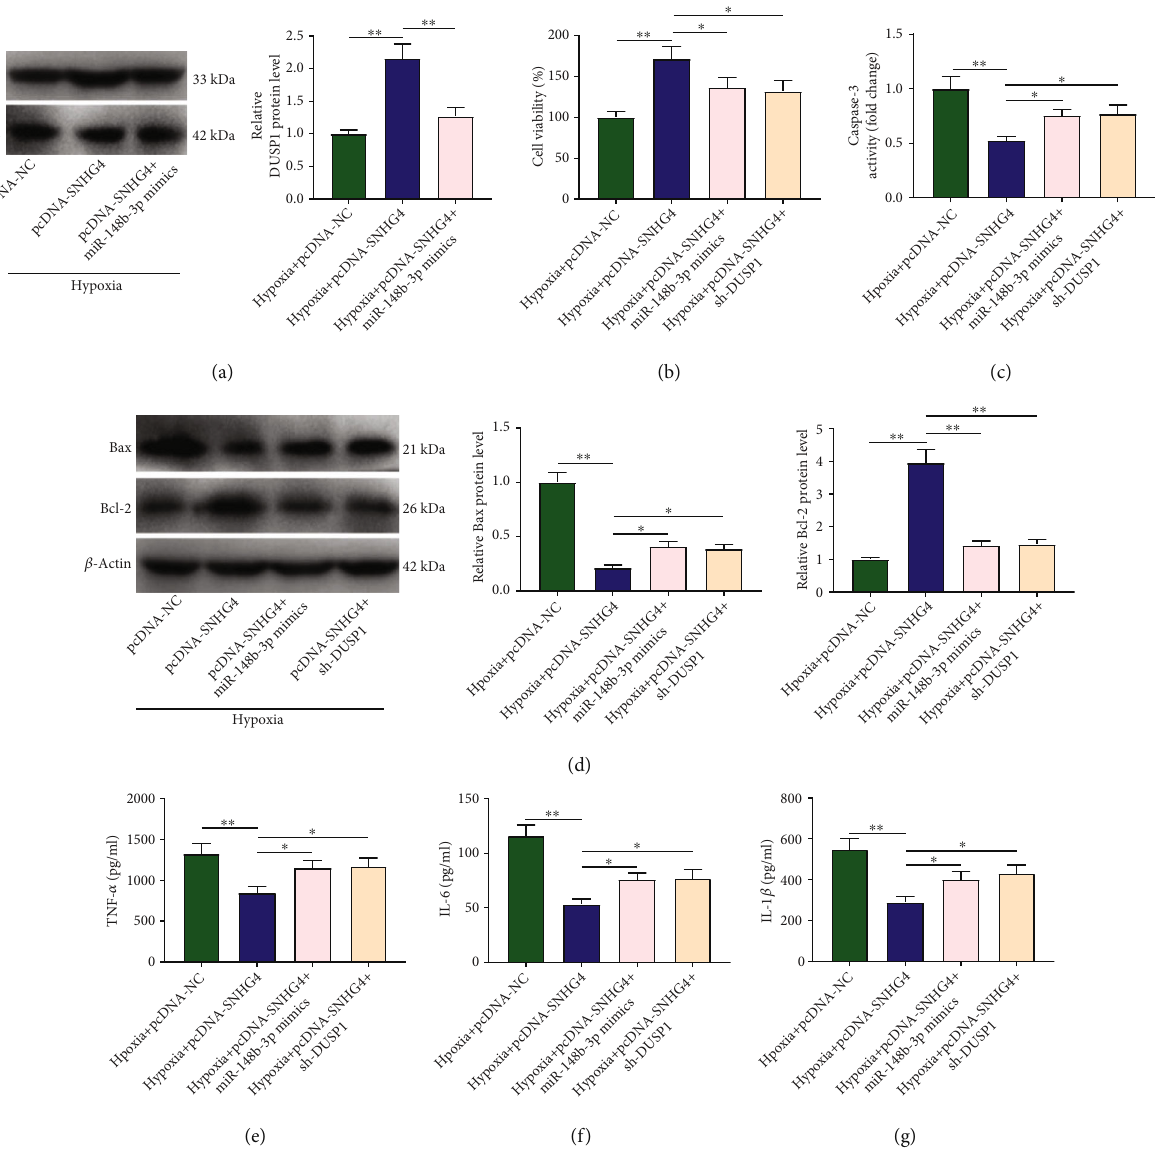
Figure 5: The regulatory mechanisms of SNHG4 involving miR-148b-3p/DUSP1 in hypoxia-induced H9c2 cells. (a) The protein expression of DUSP1 in hypoxia-induced H9c2 cells was determined by western blot. (b) Cell viability (OD450) was measured by MTT assay. (c) Caspase-3 activity. (d) The protein expression of Bax and Bcl-2 were measured by western blot. (e – g) The levels of TNF- α , IL-6, and IL-1 β were measured by ELISA. ∗ P < 0 : 05 ; ∗∗ P < 0 : 01